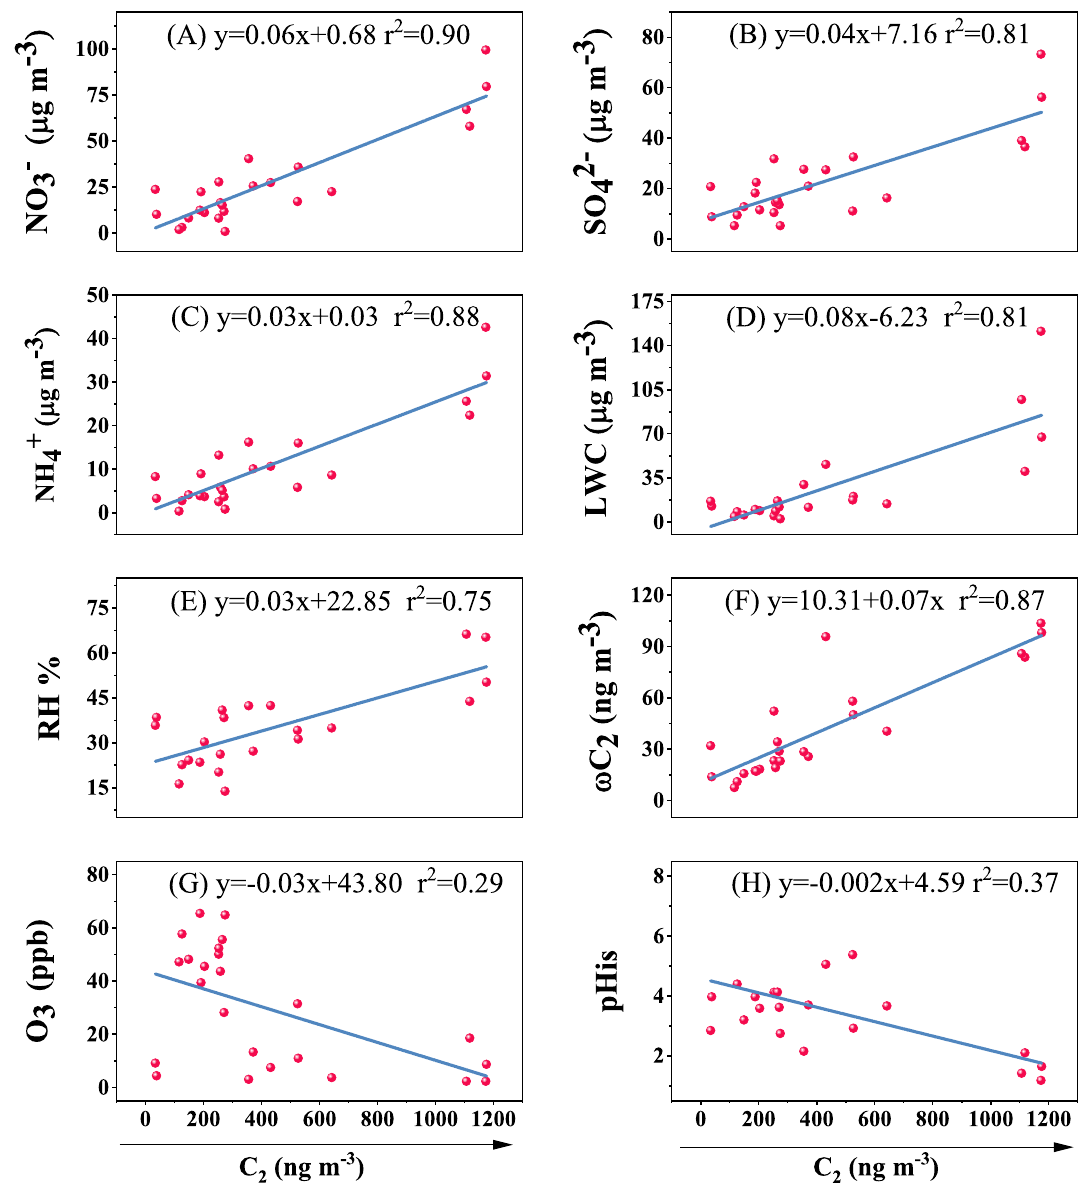
Figure 5. Linear regressions of oxalic acid (C 2 ) with NO 3− , SO 42− , NH 4+ , liquid water content (LWC), relative humidity (RH),